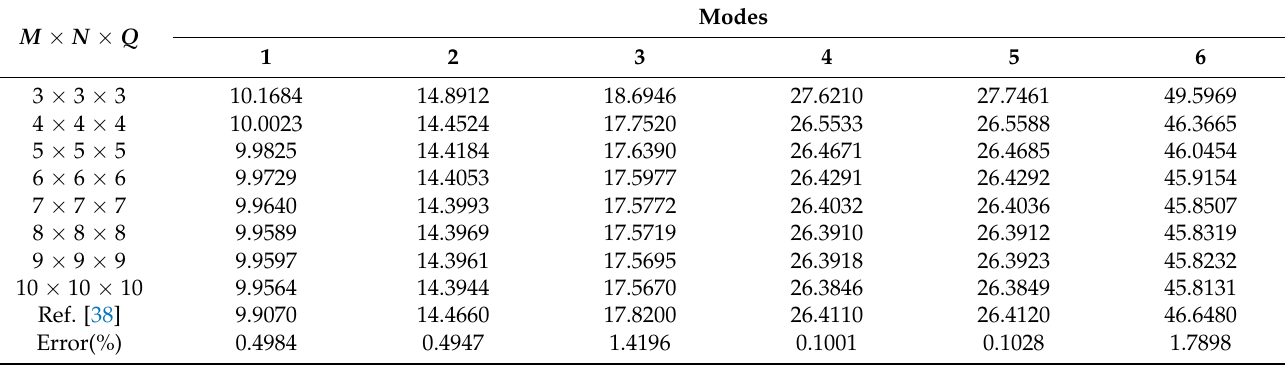
Table 2. Non-dimensional frequency parameters of FGMs square plate with a central circular cutout under FFFF-F boundary (cid:112) ρ c h / E c , a = b = 1 m, r = 0.1 m, h = 0.01 m, p = 1). condition ( Ω = ω a 2